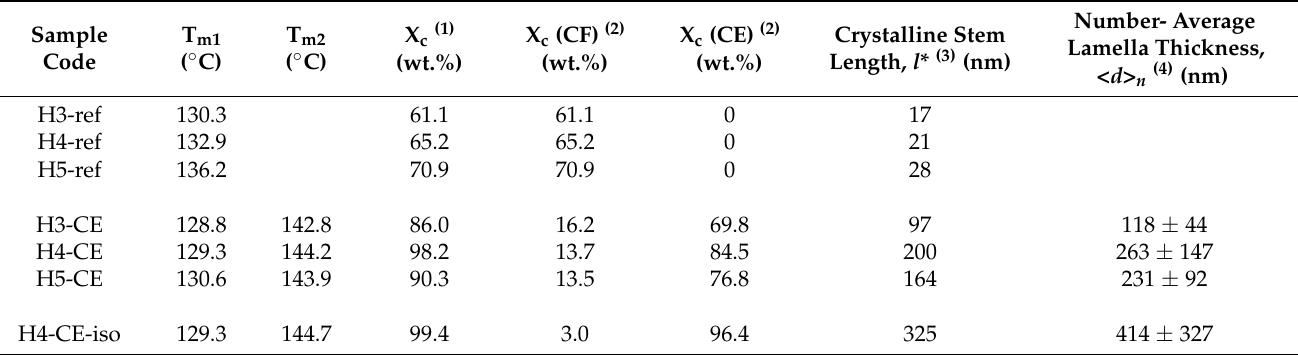
Table 2. Characteristics of the reference and CEPE samples of polyethylene derived from DSC and SEM